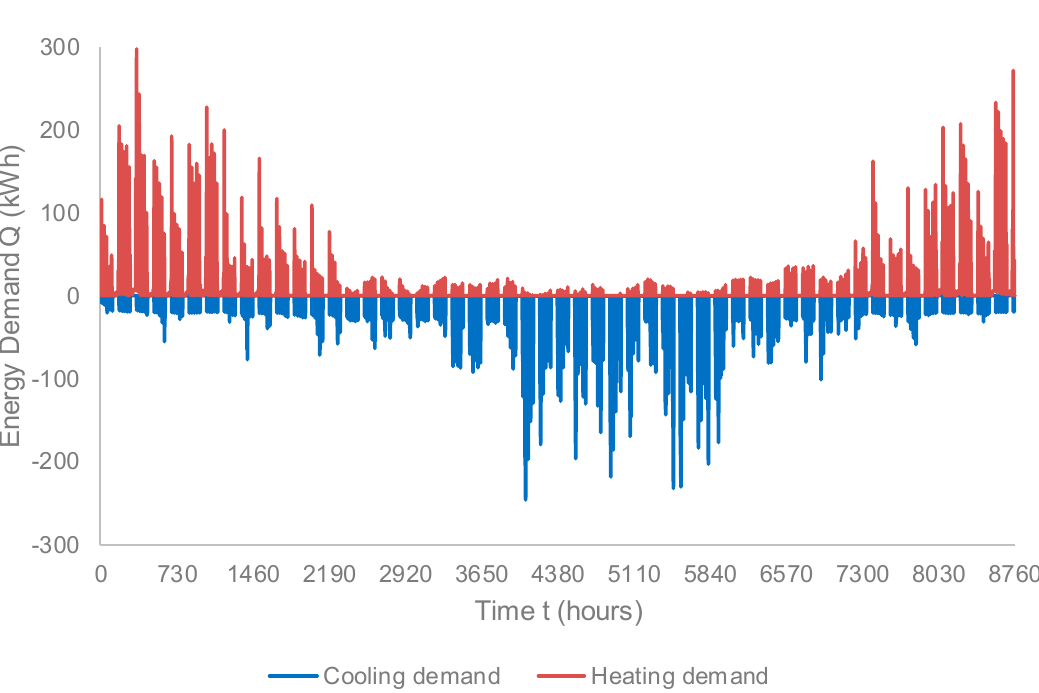
Figure 4. Example of hourly energy demand in an office building.